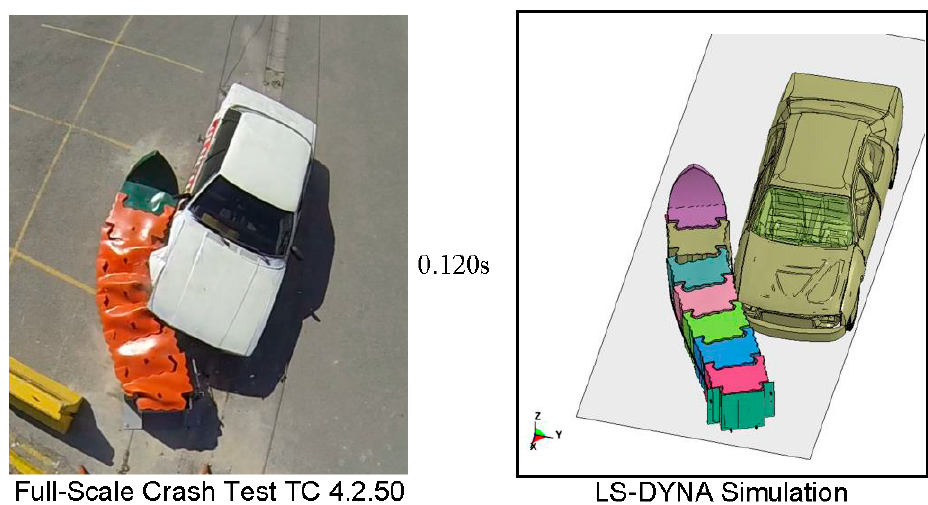
Figure 10. Sequential pictures comparison of UCC after TC 4.2.50 crash test and simulation.